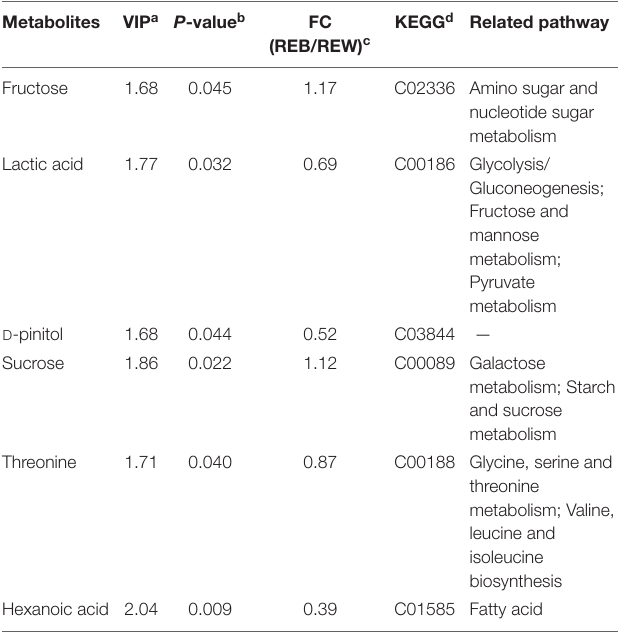
TABLE 1 | Components in tomato root exudates induced by B. cereus